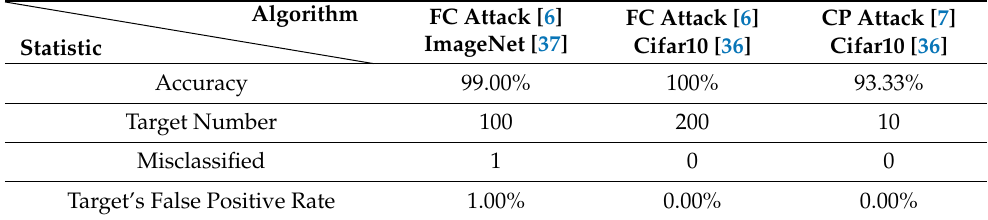
Table 5. Effects of FC and CP target attacks with Data Washing algorithm.